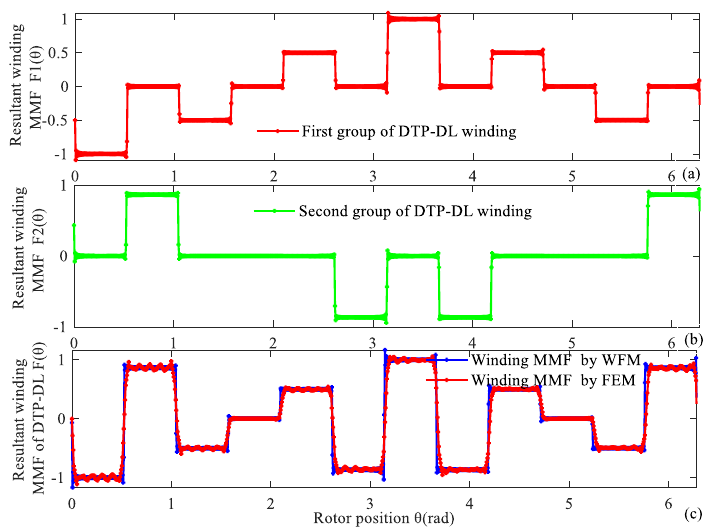
Figure 4. Resultant winding MMF of 12-slot/10-pole DTP-DL winding at time t = 0.333 × 10 −3 s. ( a ) First group of TP winding, ( b ) second group of TP winding, ( c ) two groups of TP winding validated by WFM and FEM.